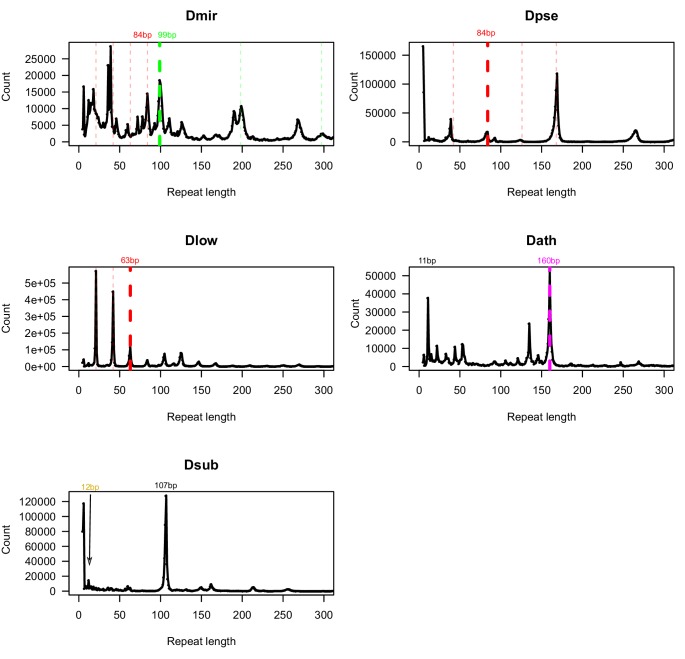
Identification of centromere-associated satellite sequences from Nanopore and PacBio reads.Shown are counts of satellite lengths identified directly from raw sequencing reads for each Drosophila species. Colored lines are drawn as in Figure 4 to highlight overlap between the results from TRF analyses and TideHunter analyses.